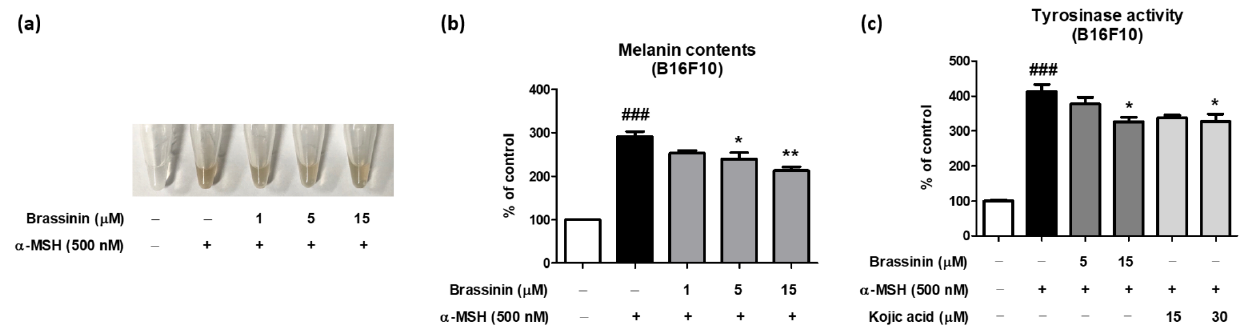
Figure 3. Anti-melanogenesis effects of brassinin in α -MSH-induced B16F10 melanoma cells. ( a , b ) In- tracellular melanin contents and ( c ) tyrosinase activity were measured in B16F10 cells pretreated with various concentrations of brassinin (1–15 µ M) and kojic acid (15, 30 µ M) for 1 h and then stimulated with α -MSH (500 nM) for 6 days ( n = 3/group). Results are presented as a mean ± SEM. ### p < 0.001 compared with the non-treated control group and * p < 0.05, ** p < 0.01 compared with the α -MSH-treated